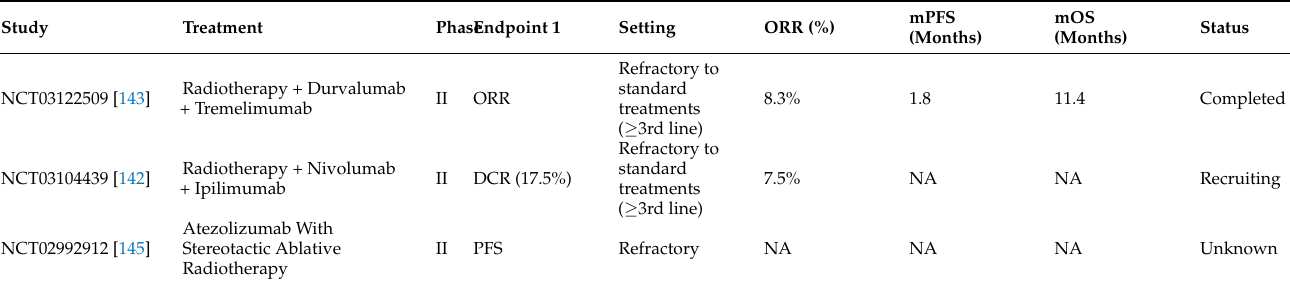
Table 9. Currently ongoing and completed clinical trials of RT and ICIs in MSS